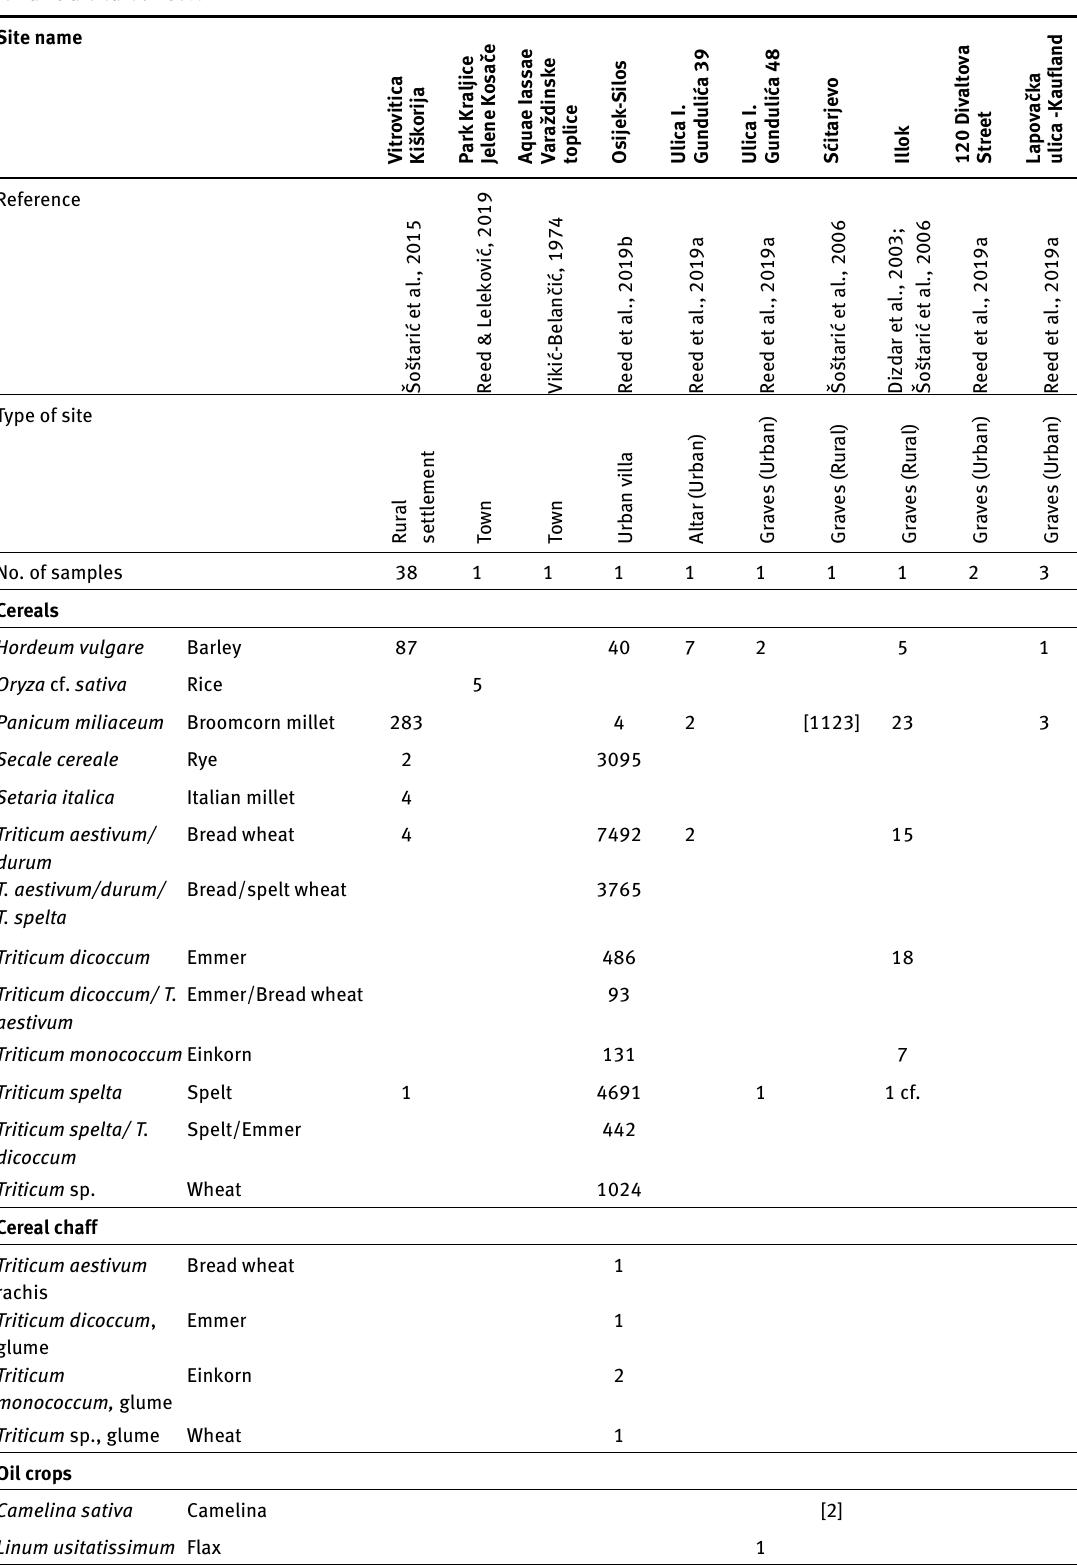
Table 2: Plant remains from Roman contexts in southern Pannonia. Numbers in [] indicate waterlogged finds, all other plant remains are carbonised